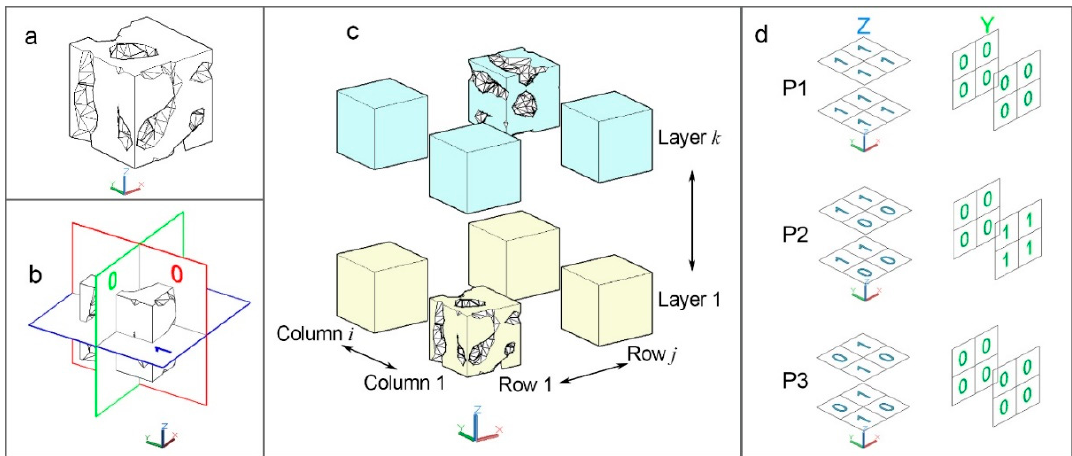
Figure 7. Tensor formation methodology for composite models: ( a ) Elementary model; ( b ) Feature value of the elementary model in the XY / XZ / YZ planes; ( c ) Positions of each elementary model in the composite model; ( d ) Tensor representation of composite models P1, P2, and P3 in feature values.